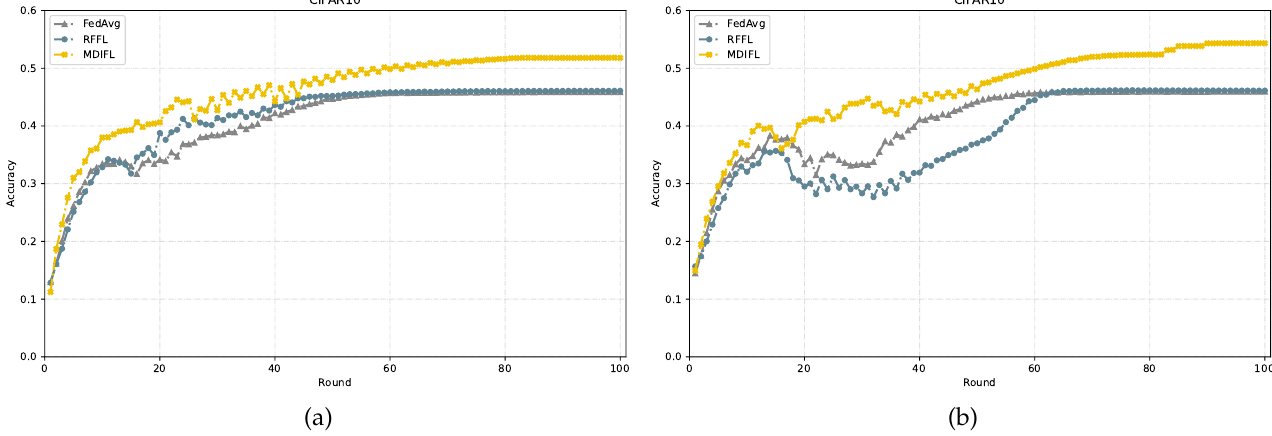
Figure 5. Accuracy comparison of MDIFL, FedAvg and RFFL. ( a ) Ten honest participants and 20% of S_P under UNI split CIFAR10. ( b ) Ten honest participants and 20% of S_P under POW split